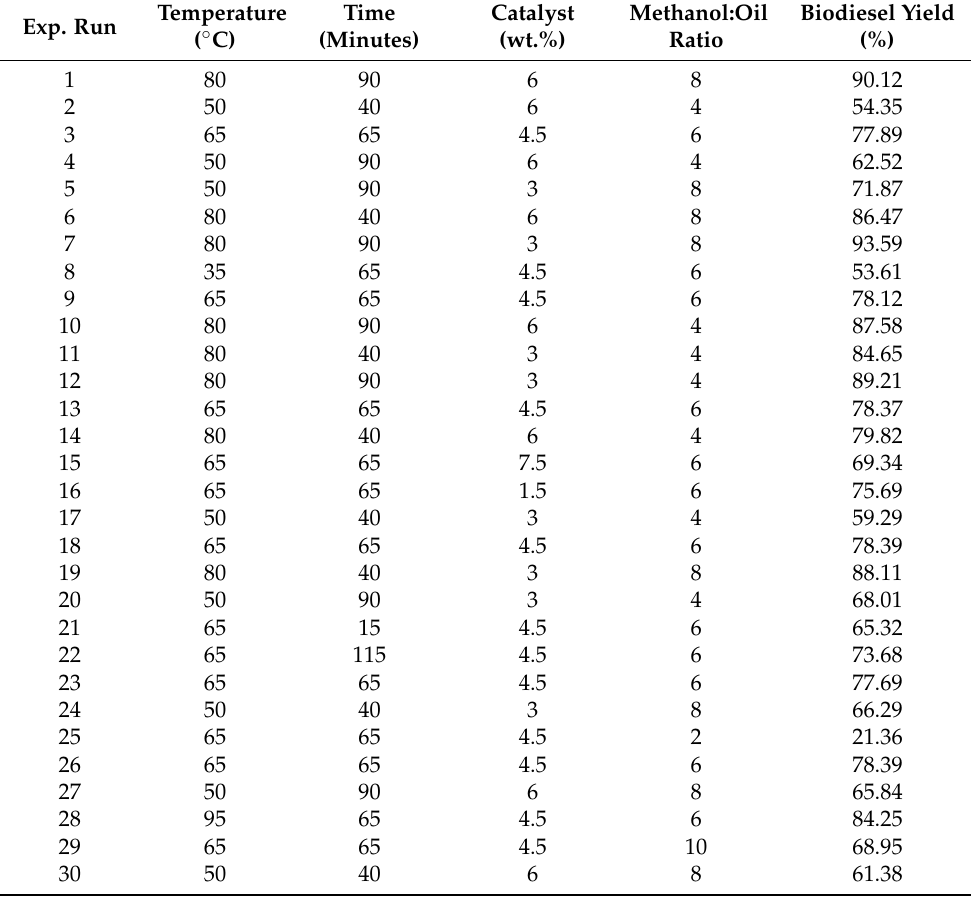
Table 2. Experimental plan, along with biodiesel yield. Exp.